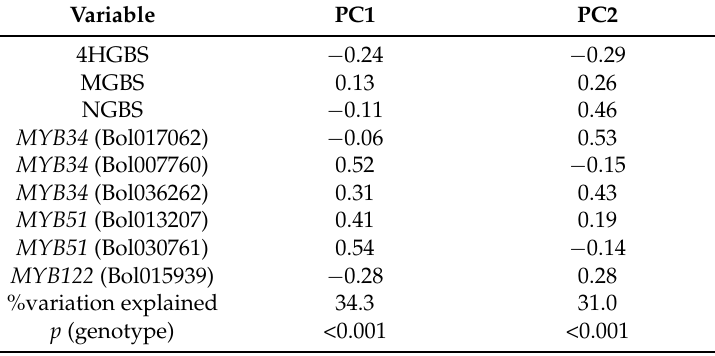
Table 2. Principal component analysis for indolic glucosinolate contents and the relative expression level of transcription factor-related genes in four cabbage lines of B. oleracea. PC, principal component; p , statistical significance; SD, standard